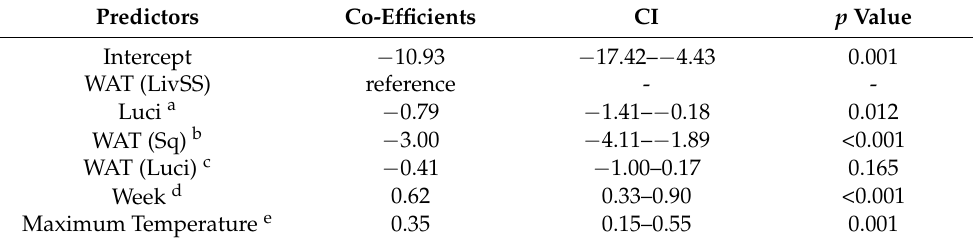
Table 5. Summary of model coefficients, confidence intervals (CI) and p values for each predictor of mean catch of Lucilia sericata . The mean catch model includes the catch of the target species and the catch of all species in each trap per